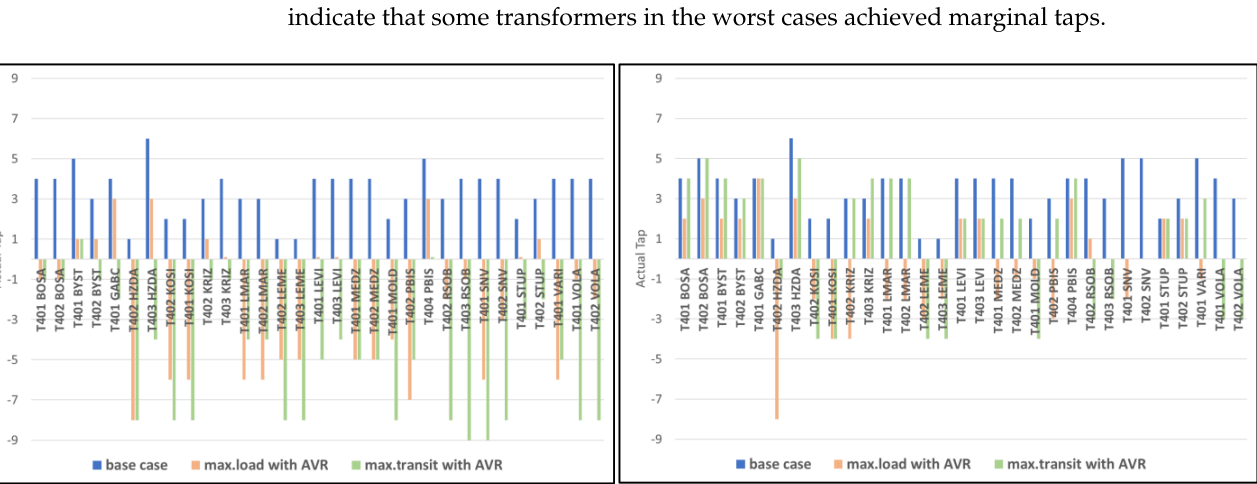
Figure 4. Position of OLTC taps on the 400 kV/110 kV transformers: winter (left), summer (right).